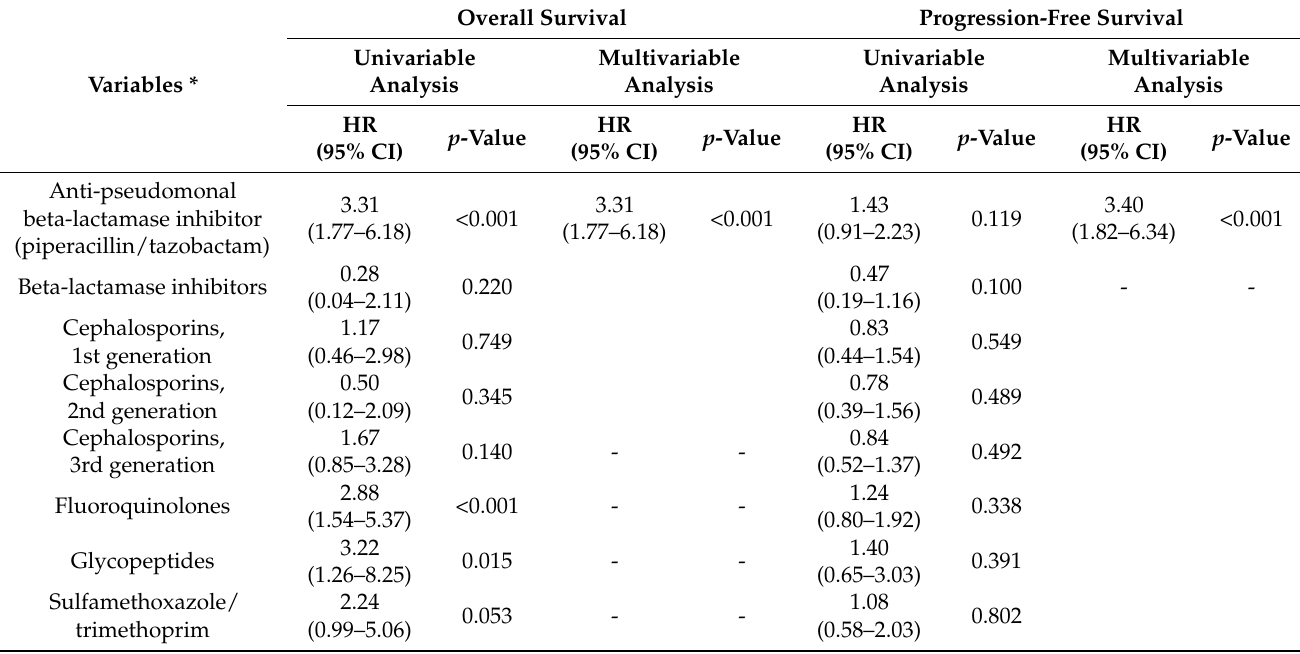
Table 2. Univariable and multivariable analyses of overall survival and progression-free survival by antibiotic class.